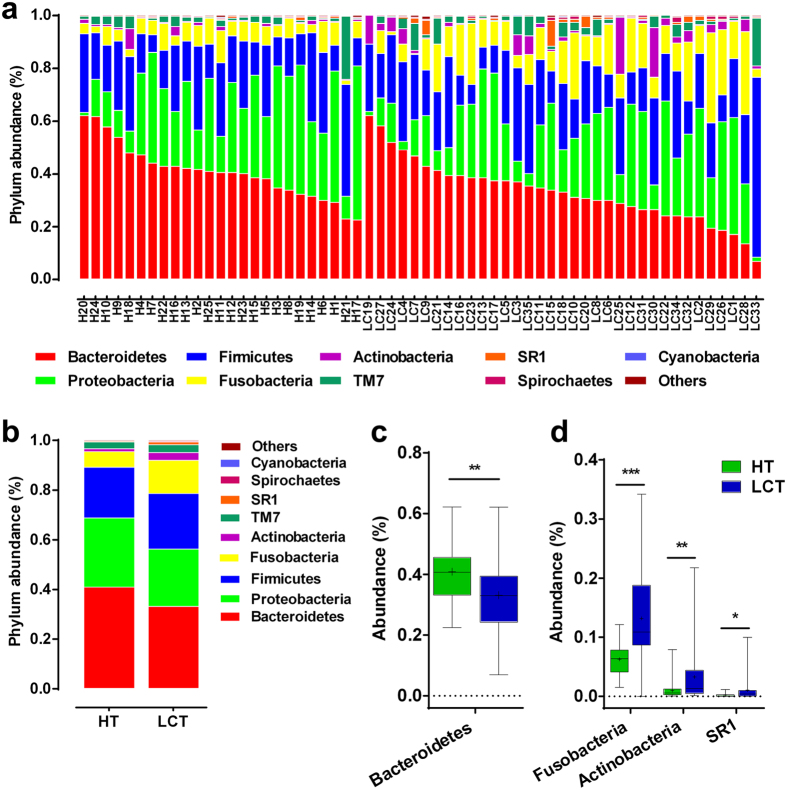
Comparison of phyla of the microbiomes between LCT and HT.(a) Comparison of the abundances of bacterial phyla of each sample; (b) Comparison of the average abundance of each bacterial phylum in the LCT and HT, respectively; (c,d) Significant differences among the abundances of discriminatory phyla between LCT (blue) and HT (green); Box parameters, the “+” symbol represents median value, and the upper and lower ranges of the box represent the 75% and 25% quartiles, respectively. p values were calculated using the nonparametric Mann–Whitney test and are shown in Supplementary Datasets S2_a. Significant differences by *p < 0.05; **p < 0.01 and ***p < 0.001. LCT, liver cancer patients tongue coat; HT, healthy subjects tongue coat.